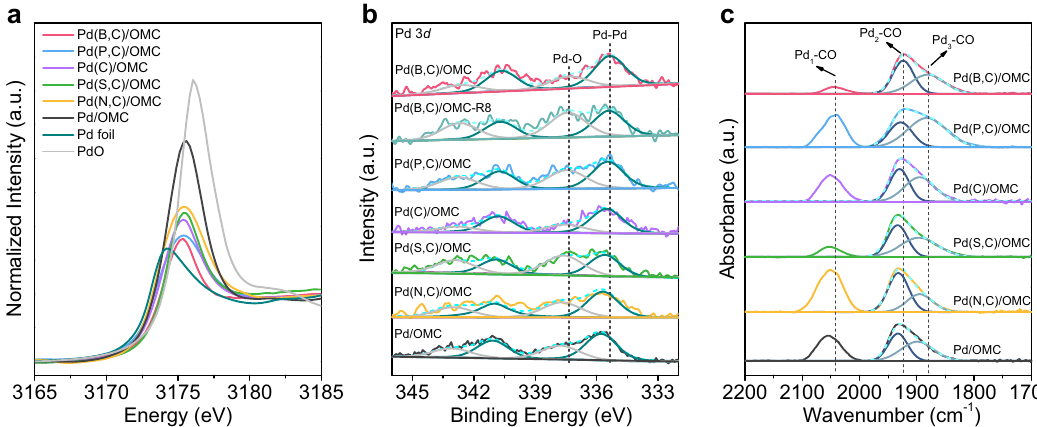
Fig. 2 Electronic properties. a XANES spectra of the Pd L 3 -edge of Pd interstitial nanocatalysts, reference Pd/OMC catalyst, and reference samples (Pd foil and PdO). b XPS spectra of the 3 d level of Pd with Pd binding energies fi tting by peak fi tting programs. Pd(B,C)/OMC-R8 is the Pd(B,C)/OMC catalyst after eight catalytic runs. c CO-DRIFTS spectra with schemes identifying the distinct adsorption modes for Pd interstitial nanocatalysts and the reference Pd/OMC